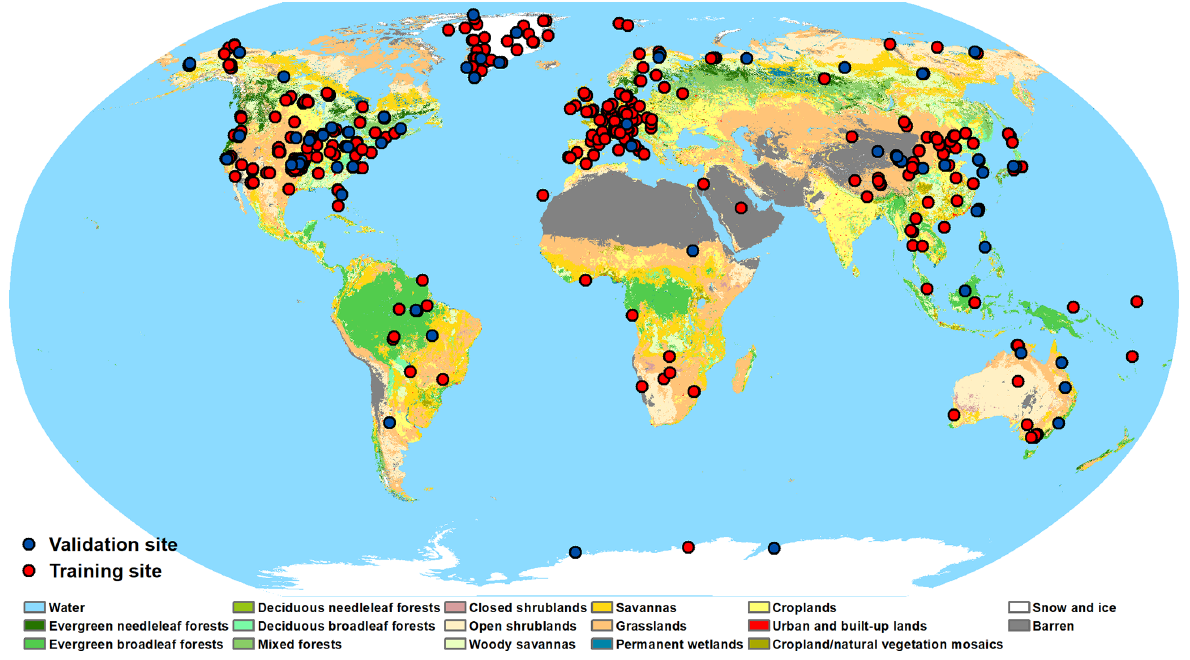
Figure 1. Geographic locations of the 522 ground stations used in this study. The 448 stations marked with red circles are used to train the RCNN model, while the other 74 stations marked with blue circles are used for the independent validation of the resulting trained model. Background colors indicate different land cover according to the International Geosphere-Biosphere Programme (IGBP) classification system.